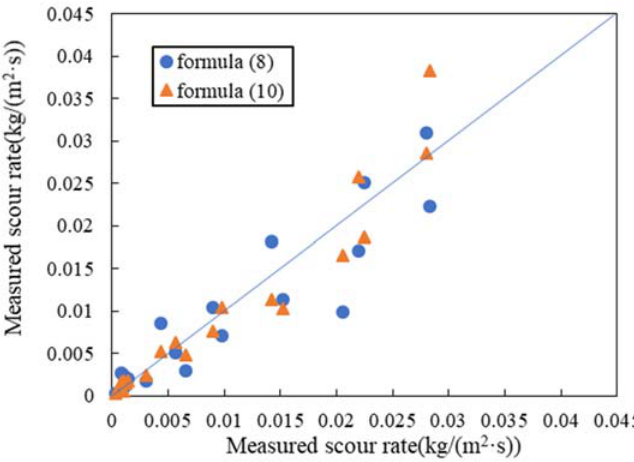
Figure 14. Comparison of measured and calculated values.